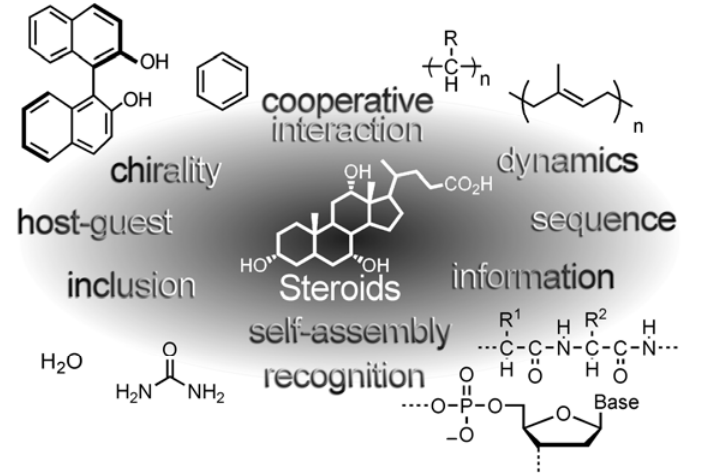
Figure 5. Intermediate properties of crystalline assemblies of steroidal bile acids and their derivatives, which relate to supramolecular chemistry.